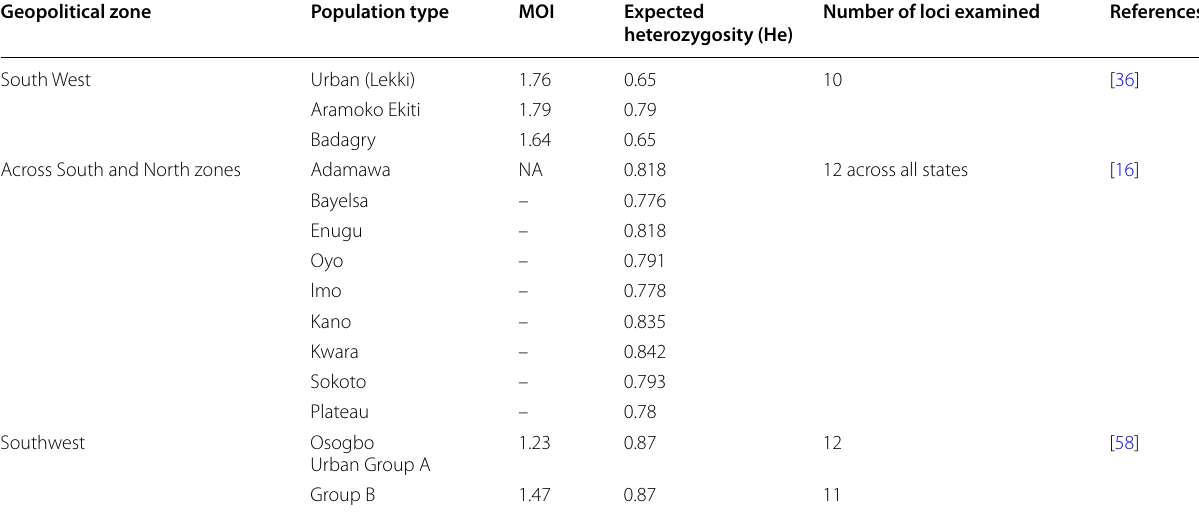
Table 4 Microsatellite marker for P. falciparum reported in some parts of the country Geopolitical